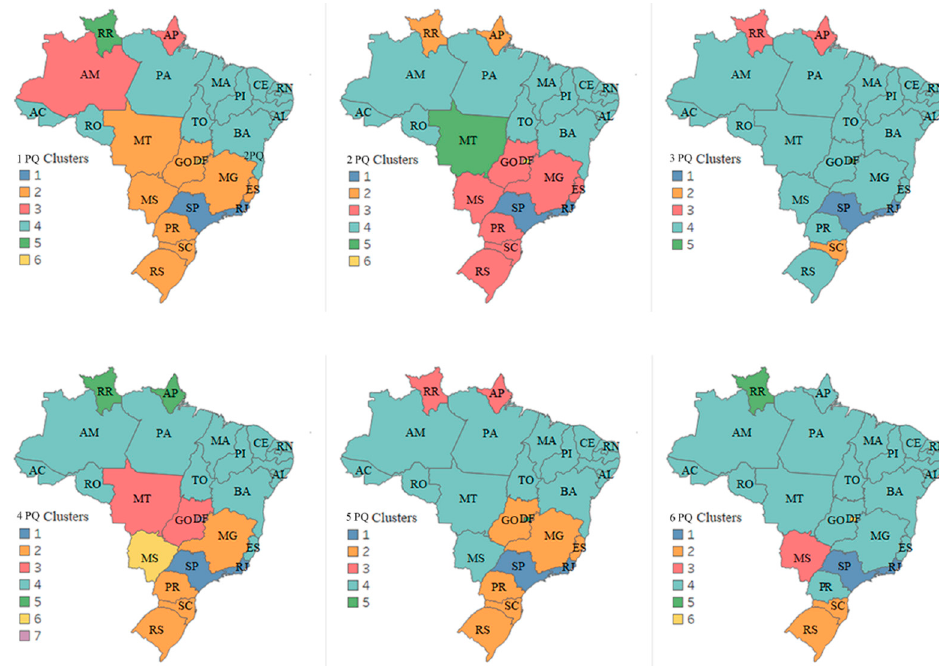
Figure 6. Clustering of Brazil in the pandemic quarters—Infodemic and social inequality. States assigned to the same cluster share the same color.